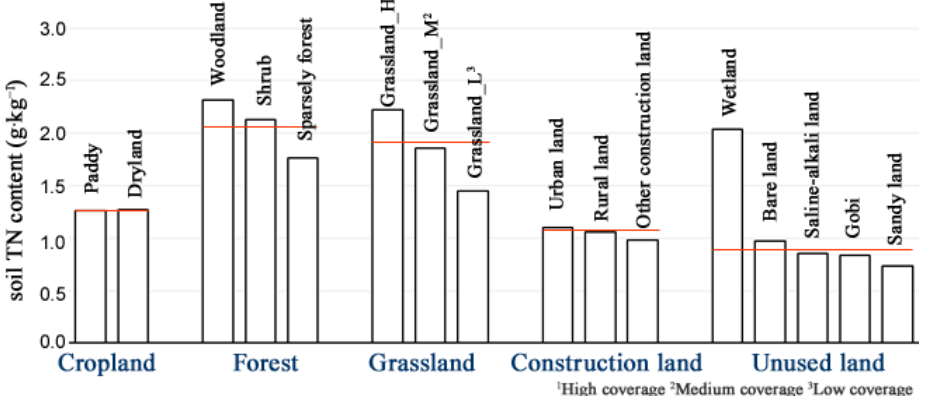
Figure 8. Mean soil TN content (g·kg −1 ) in different land-use types in China.